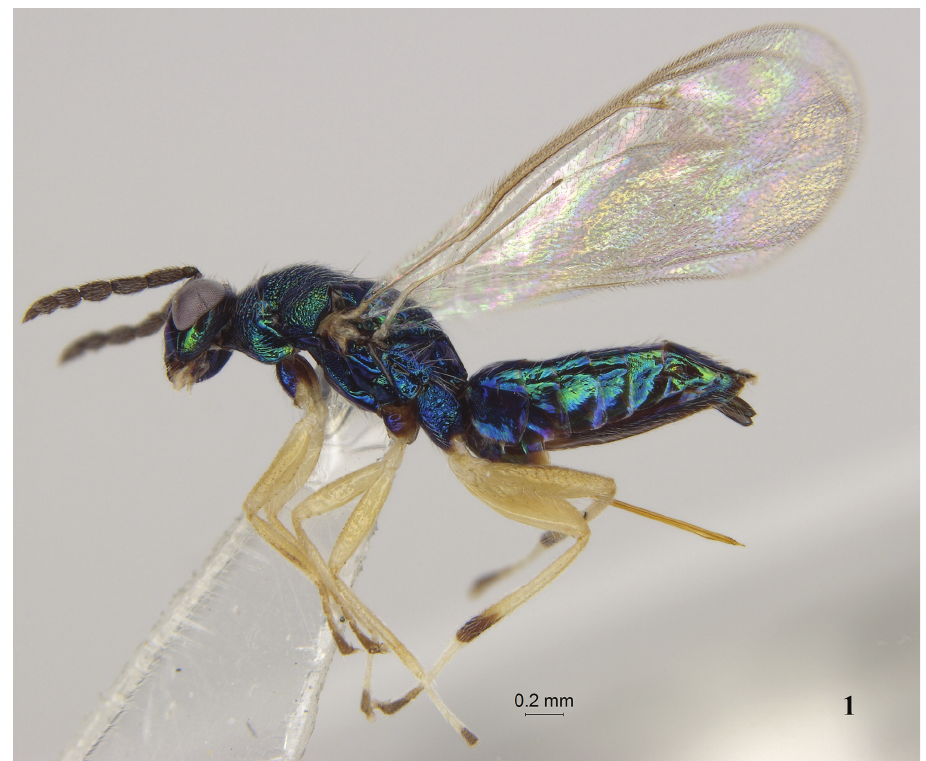
Figure 1. Pnigalio eriocraniae Li & Yang, sp. n., female, holotype, habitus